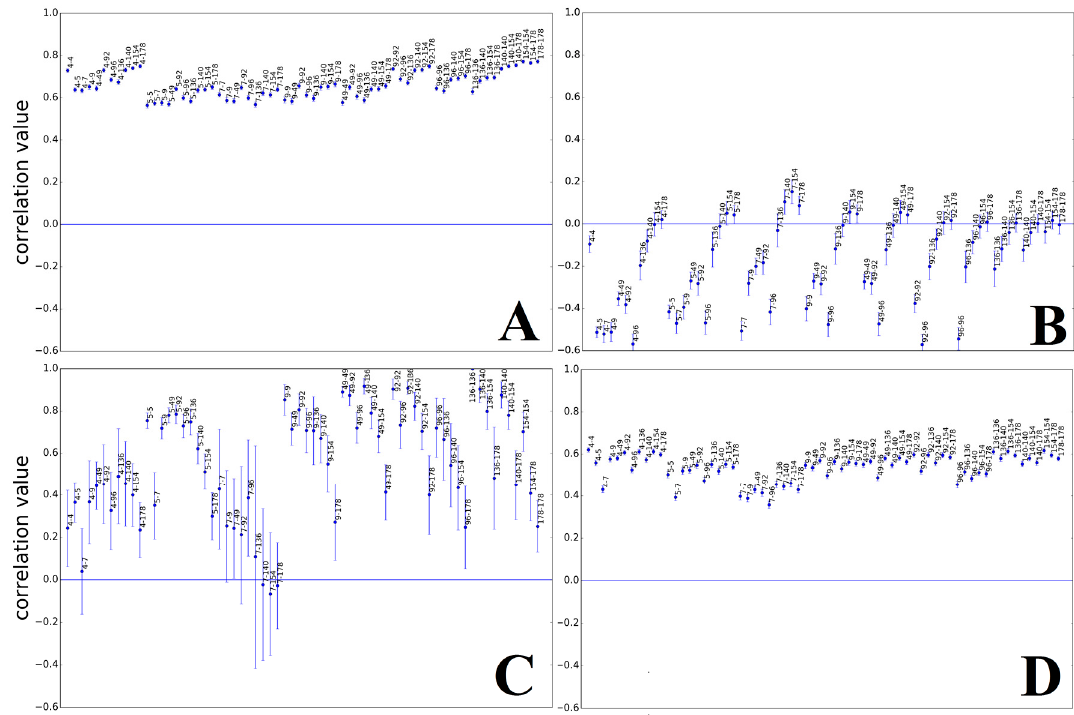
Figure 5. Heatmap Summary Images of HPV Regions. Shown are the summaries of some heatmaps ( k = 1) of the three regions defined by different k -mer contents for all of the HPV types analyzed (positions of regions can be found in Table S1). ( A ) Good correlation within the first region between all HPV types; ( B ) Bad correlation (values around zero or lower) between the first and second region; ( C ) Relatively good correlation in the second region for most values; ( D ) Good correlation amongst all of the third regions of HPV. The data points are equally spaced and sorted numerically, therefore no additional information is provided by their horizontal alignment. The labels next to the data points indicate the corresponding HPV types whose regions were correlated.